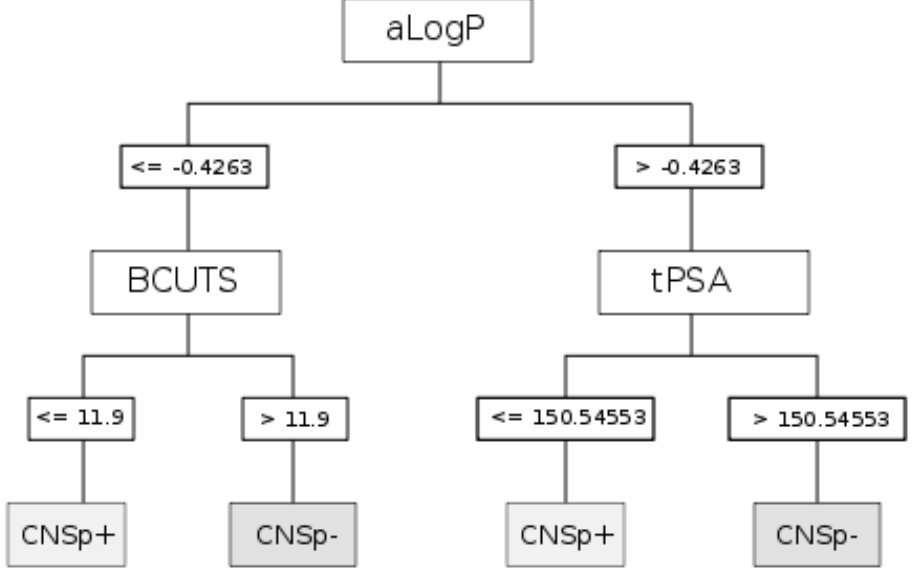
Figure 2. Classification and regression tree (CART) based on CDK descriptors. Prediction of strong (CNSp+, grey boxs) or weak (CNSp − , grey boxes) blood-brain barrier permeation is based on the splitting criteria (white boxes) of partition coefficient (aLogP), topological polar surface area (tPSA), and the number of highest eigenvalue of the Burden matrix weighted for the lowest atomic